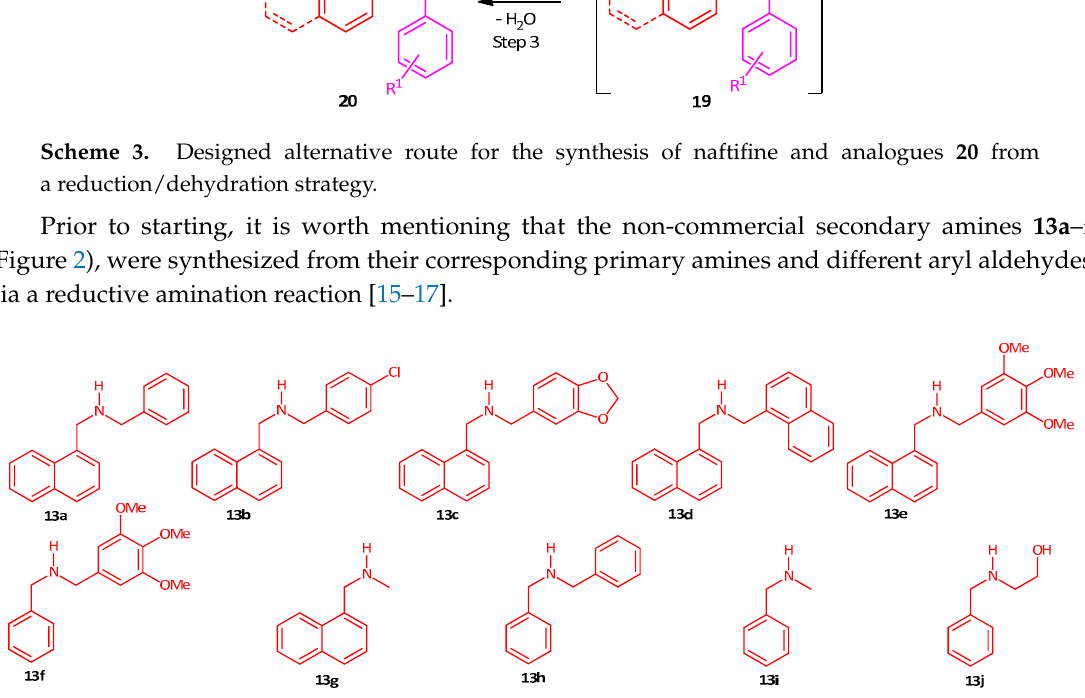
Figure 2. Set of secondary amines 13 used for the synthesis of the intermediate γ -aminoalcohols 15 .